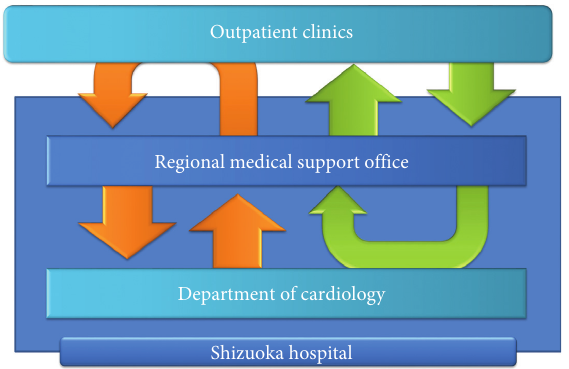
Figure 1: Flowchart of the ischaemic heart disease referral